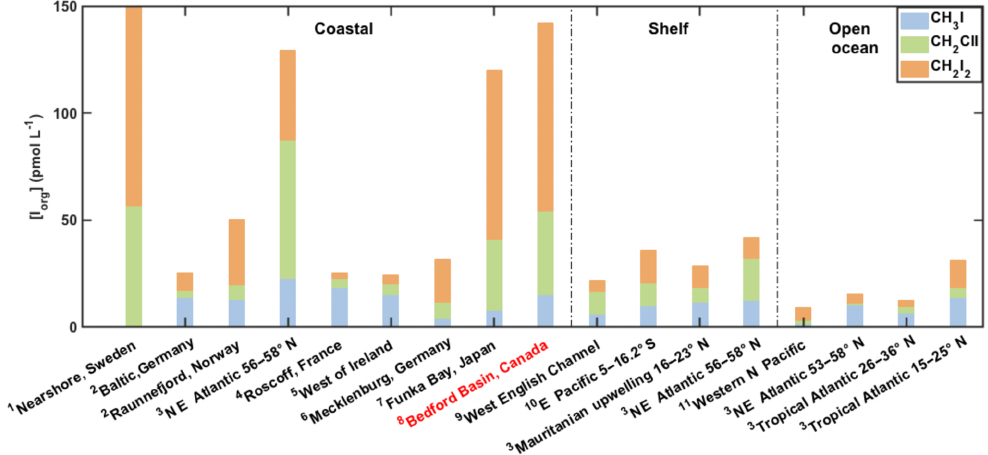
Figure 7. Contribution of iodocarbons to total organic iodine ( I org ) in surface seawater from different regions and studies. 1: Klick (1992); 2: Orlikowska et al. (2015); 3: Jones et al. (2010); 4: Jones et al. (2009); 5: Carpenter et al. (2000); 6: Orlikowska and Schulz-Bull (2009); 7: Shimizu et al. (2017); 8: this study; 9: Archer et al. (2007); 10: Hepach et al. (2016); 11: Kurihara et al.